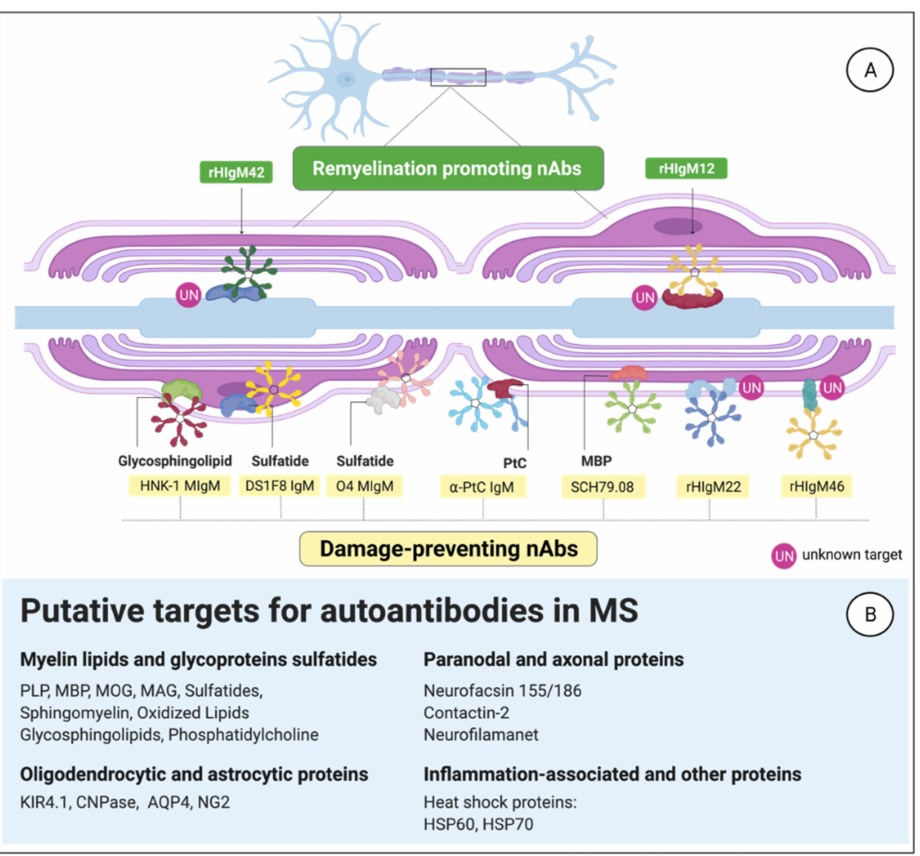
Figure 4. Natural antibodies evolved to fulfill homeostatic functions in the central nervous system (CNS). ( A ) Examples of IgM that can bind myelin or axonal antigens to exert housekeeping functions. ( B ) Putative antigenic candidates in the CNS may play a role in multiple sclerosis